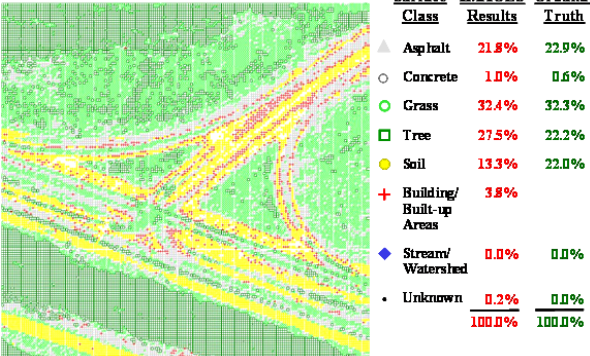
Figure 2: Intersection of Highway 6 and Jackson Ave in Oxford, Mississippi, used for one of the groundtruth studies. The surface class data are used to predict surface temperature using climatological data for the study area. The results of 8 km x 8 km study area of oxford show that on a hot summer day the average surface temperature in the built-up area within the city has an average 9 o C higher surface temperature than the ambient air temperature. This shows the “heat-islands” effect for this small rural